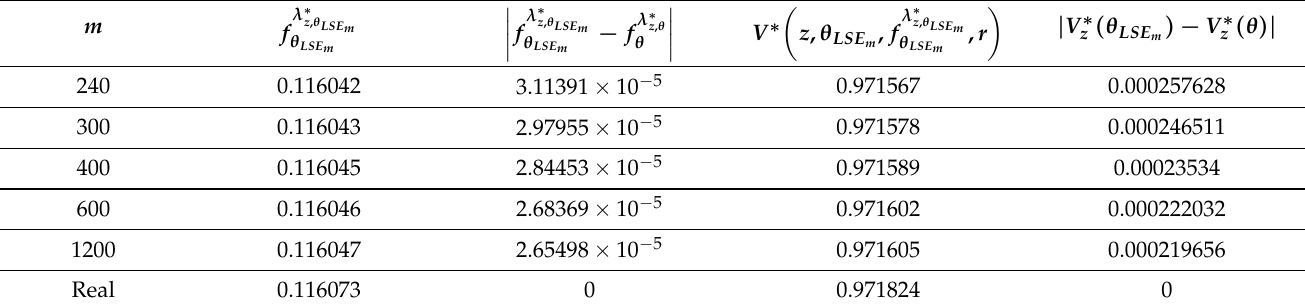
Table 3. Estimated processes and the real processes ( θ = 2.5) with σ = 0.0001.